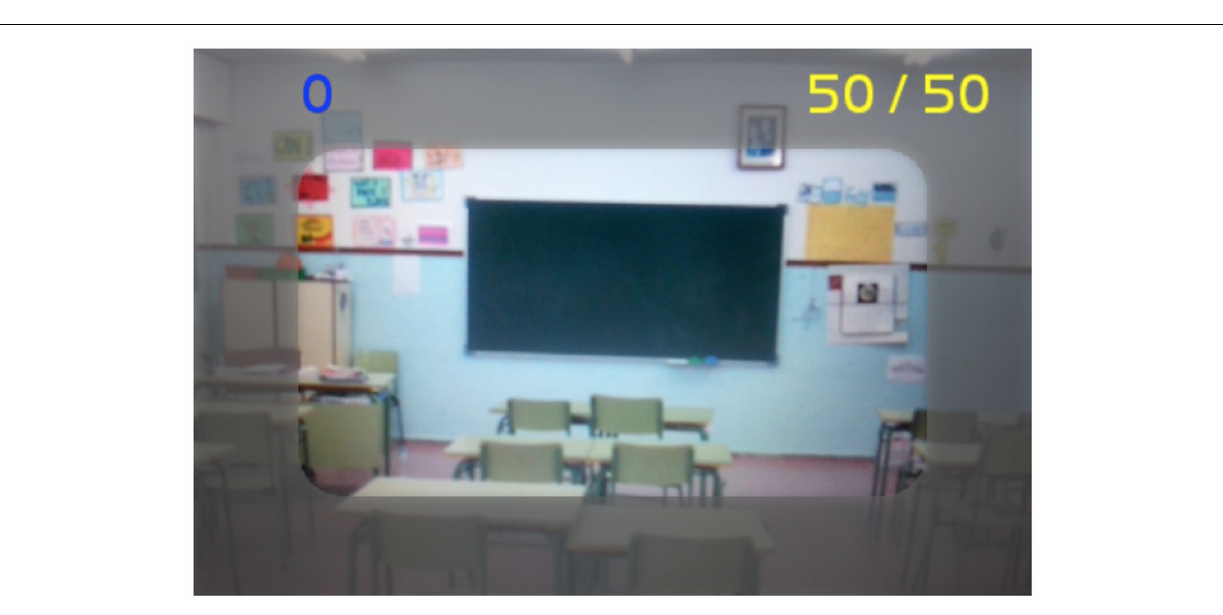
FIGURE 7 | Mobile screen without selecting a fellow